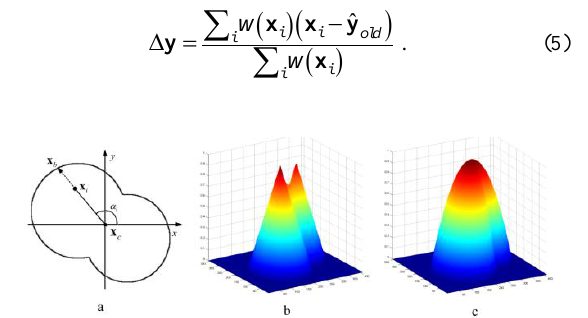
Figure 2. Object and object-shaped kernel. (a) An irregular- shaped object. (b) The level set kernel. (c) The proposed kernel. Object-Shaped Scale Invariant Mean Shift